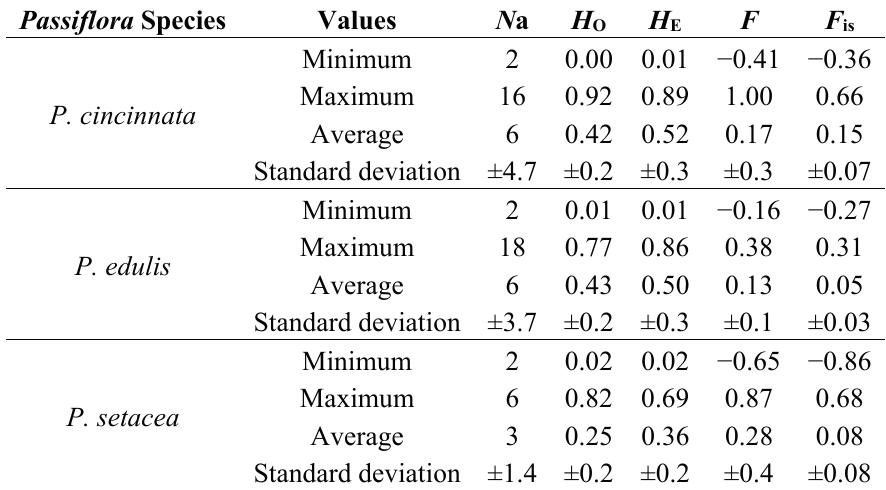
Table 2. Descriptive statistics for the characterization of accessions of P. cincinnata (24 accessions and 22 microsatellite loci), P. edulis (85 accessions and 23 microsatellite loci) and P. setacea (7 accessions and 25 microsatellite